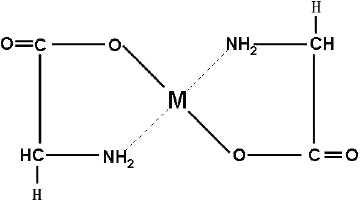
Fig. 1. The structure of chelated metal